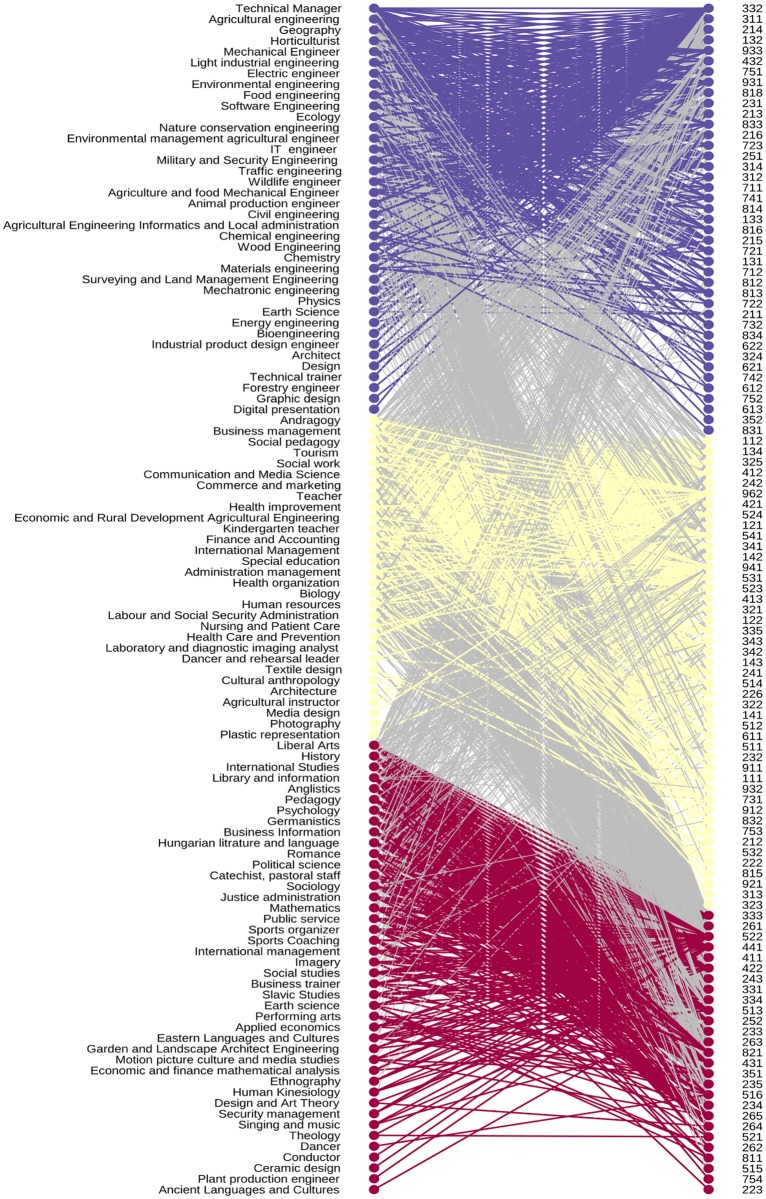
Clustering and reordering of the bipartite graph with Barber algorithm.